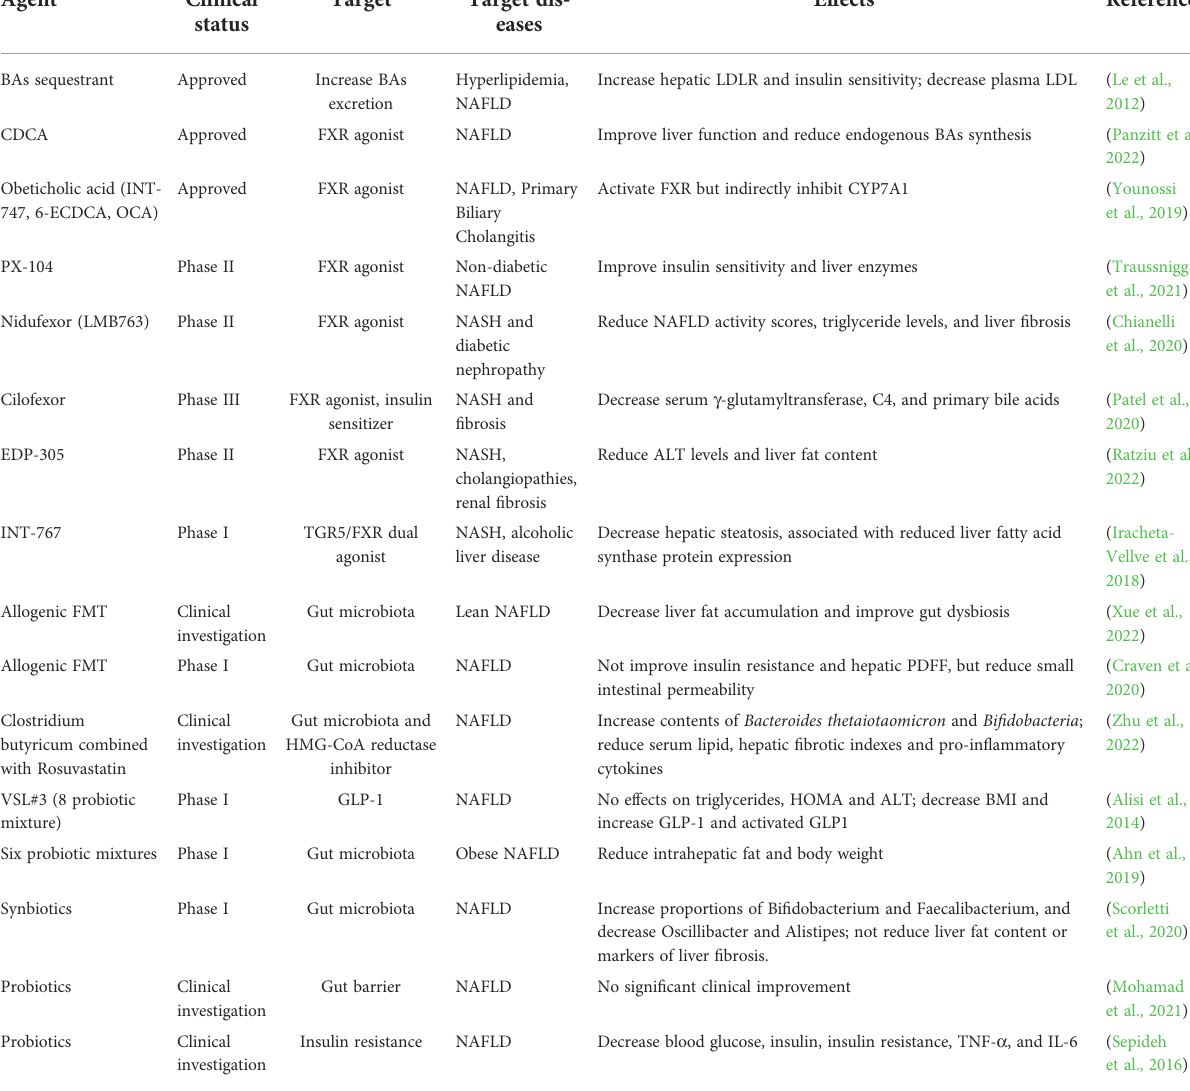
TABLE 1 Current clinical status of targeting gut microbiota-related agents for NAFLD